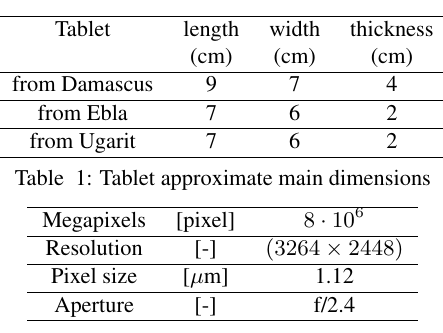
Table 2: iPad Air 2 rear camera